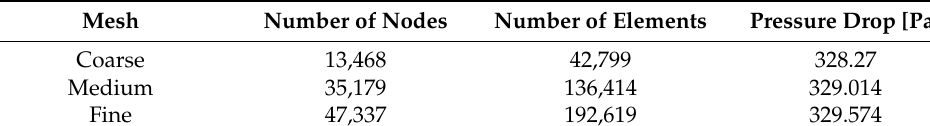
Figure 5. Sections of meshed geometry: ( a ) coarse mesh, ( b ) medium mesh, and ( c ) fine mesh. Table 3. Results of mesh-independence study.